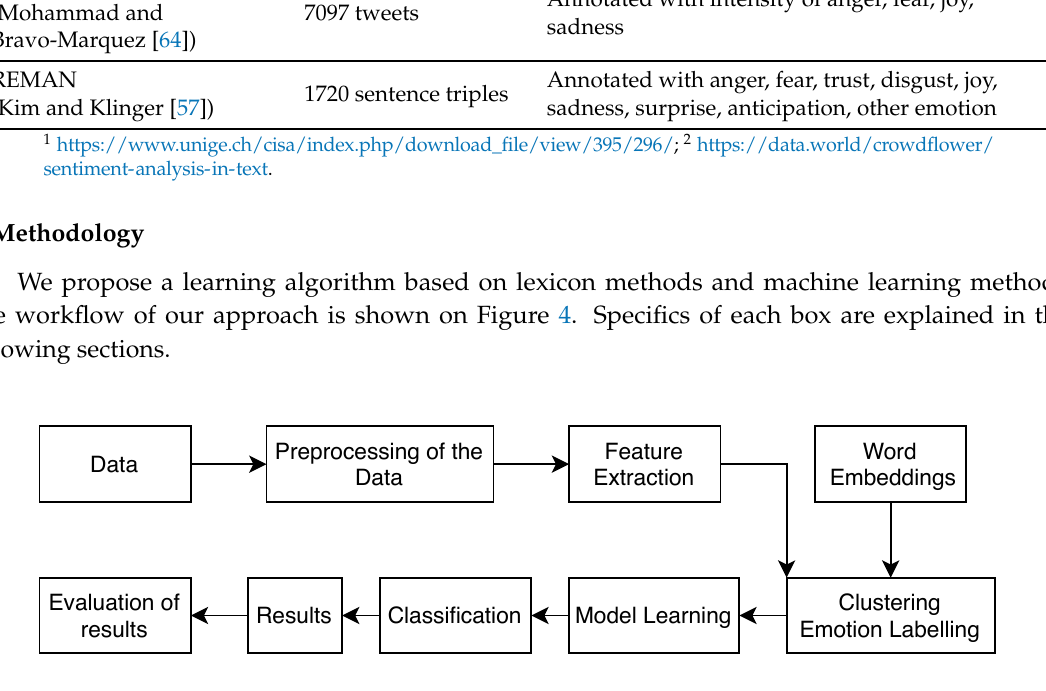
Figure 4. Emotion detection flow chart